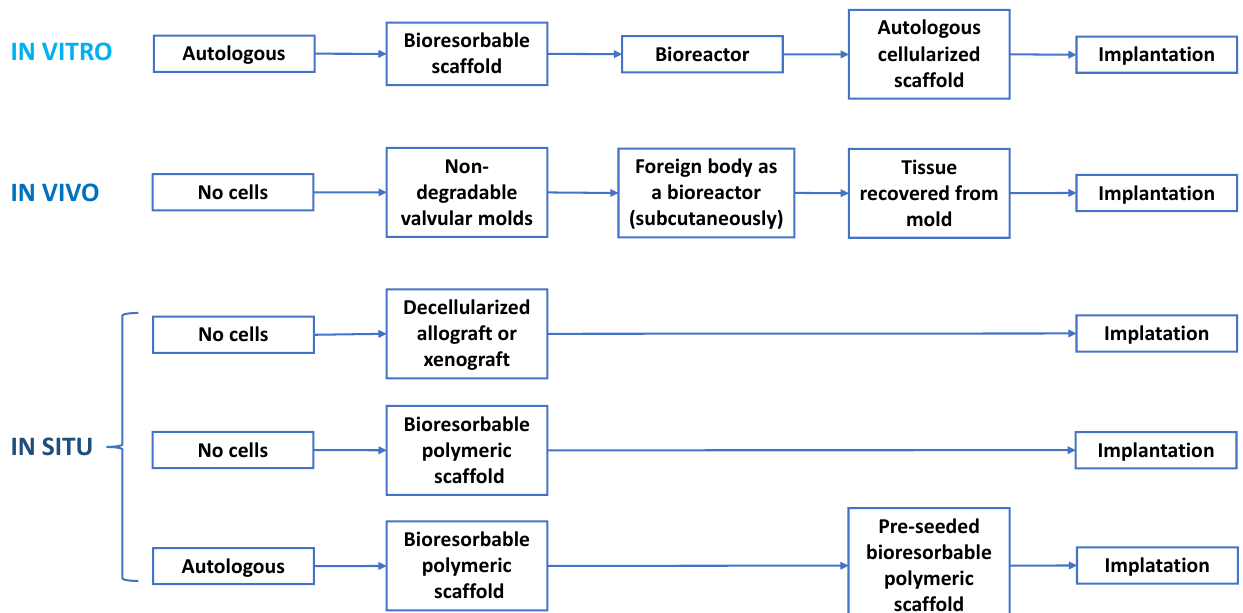
Figure 8. Heart valve tissue engineering strategies : in vitro TEHV, in vivo TEHV and in situ TEHV.